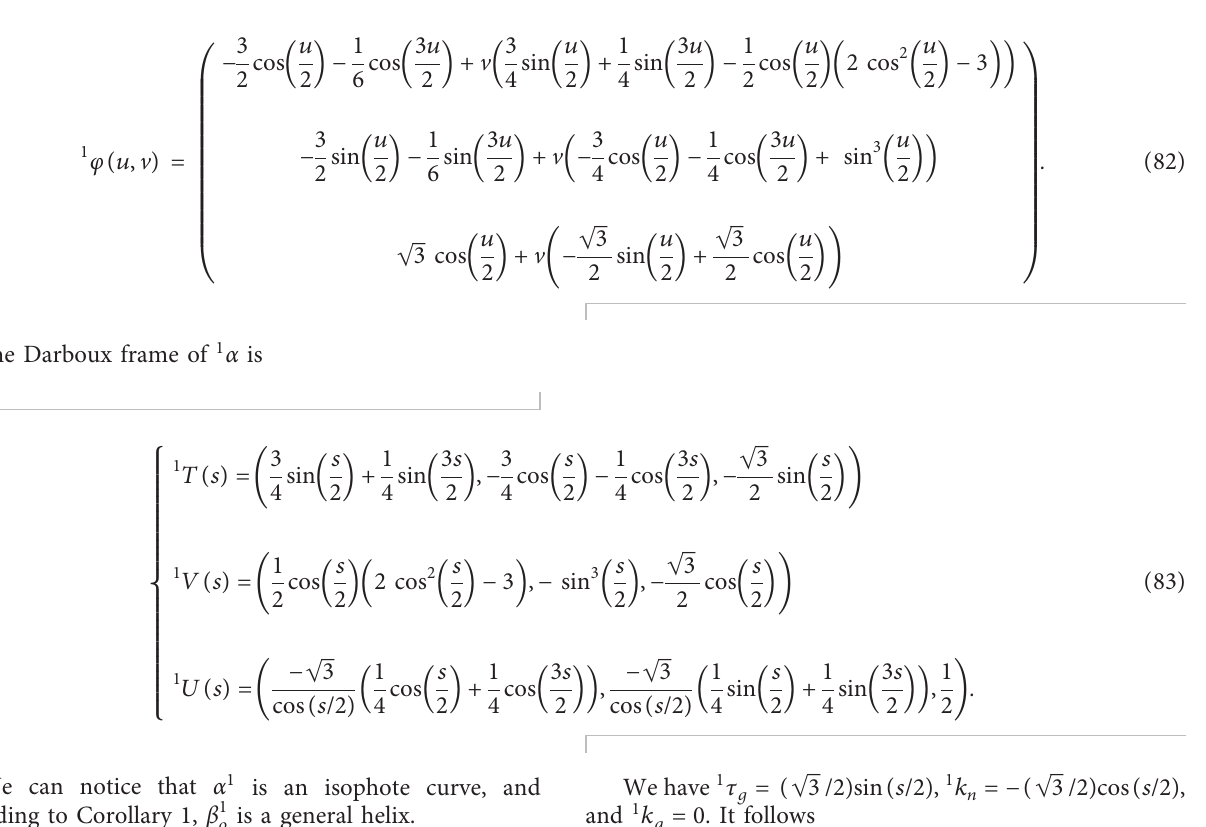
Figure 1: The curve 1 α (blue) lying on the surface 1 M